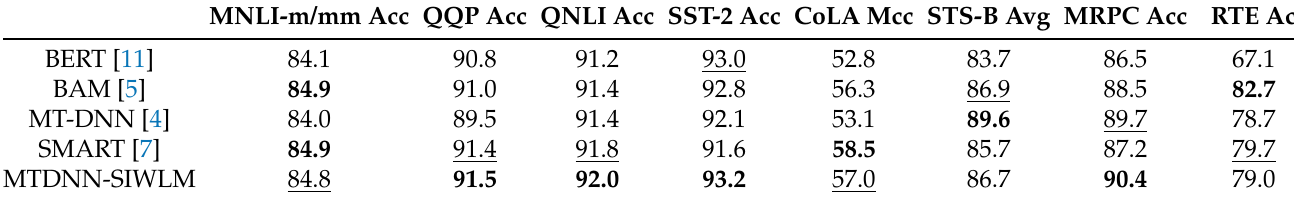
Table 3. Validation performance of reproduced models and MTDNN-SIWLM. The best result is in bold font and the second-best result is underlined. For STS-B, we attain the performance by averaging the Pearson and Spearman correlations.